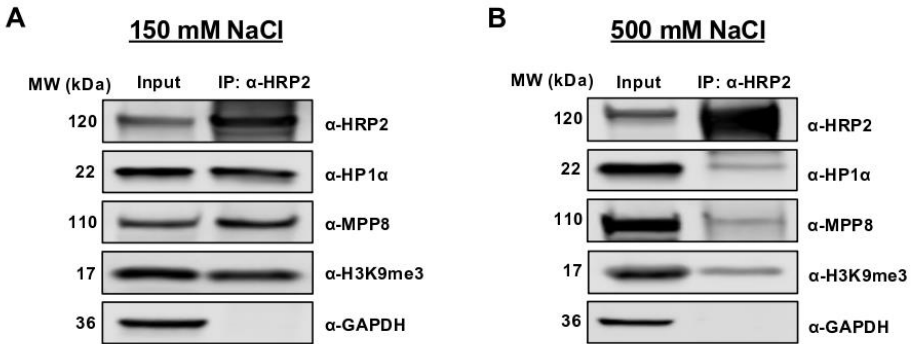
Figure 2. HRP2 stably interacts with HP1 α , MPP8, and H3K9me3 at increasing salt concentrations. ( A ) HRP2 strongly co-immunoprecipitates with HP1 α , MPP8, and H3K9me3, and does not interact with GAPDH (negative control) at 150 mM NaCl. ( B ) HRP2 maintains association with HP1 α , MPP8, and H3K9me3 but does not interact with GAPDH (negative control) at 500 mM NaCl. To generate an HRP2 knockout (HRP2 KO ) line in 293Ts, cells were transfected with